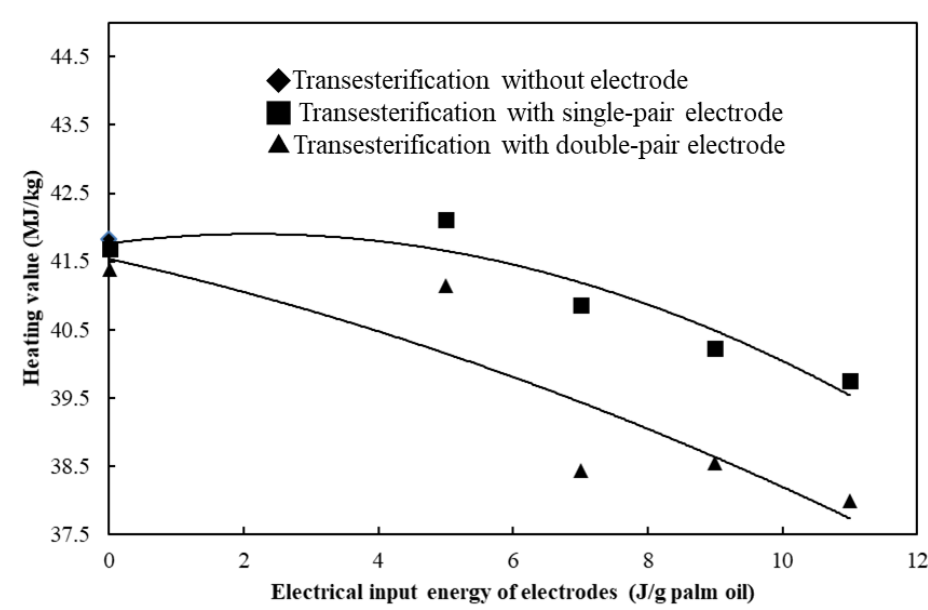
Figure 5. Effects of electrical energy input to electrodes for dissociating water on the heating value of biodiesel product.